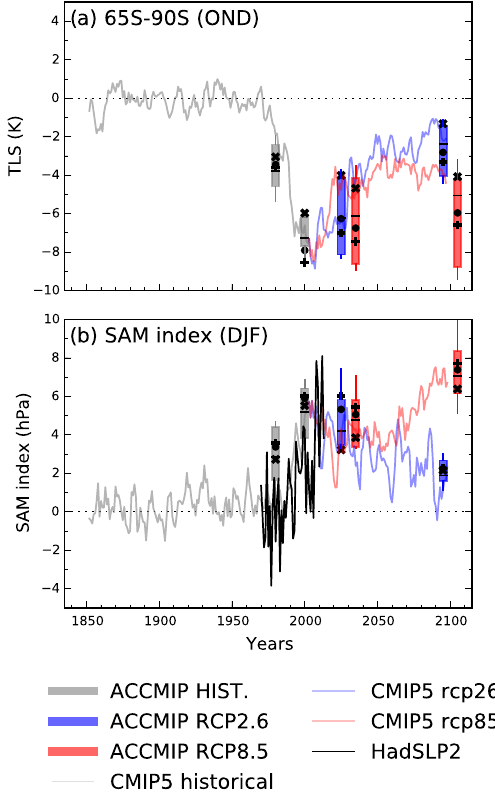
Figure 7. (a) MSU temperature lower stratosphere (TLS) and (b) SAM index time series from 1850 to 2100. The box, whiskers, line, dot, “plus”, and “cross” symbols show the interquartile range, 95% range, median, multi-model mean, CHEM, and NOCHEM means respectively, for the ACCMIP models. The 5-years average of the CMIP5 multi-model mean is shown. In addition, HadSLP2 obser- vational data set for (b) is represented by a solid black line. The ACCMIP models are normalized to Hist 1850 time slice levels, and the HadSLP2 data set and CMIP5 models are relative to 1860–1899